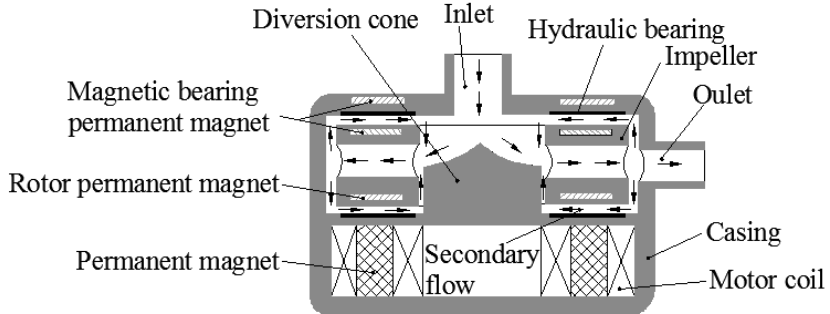
Figure 1. Schematic diagram of the blood pump. The arrow indicates the blood flow path and the secondary flow path.